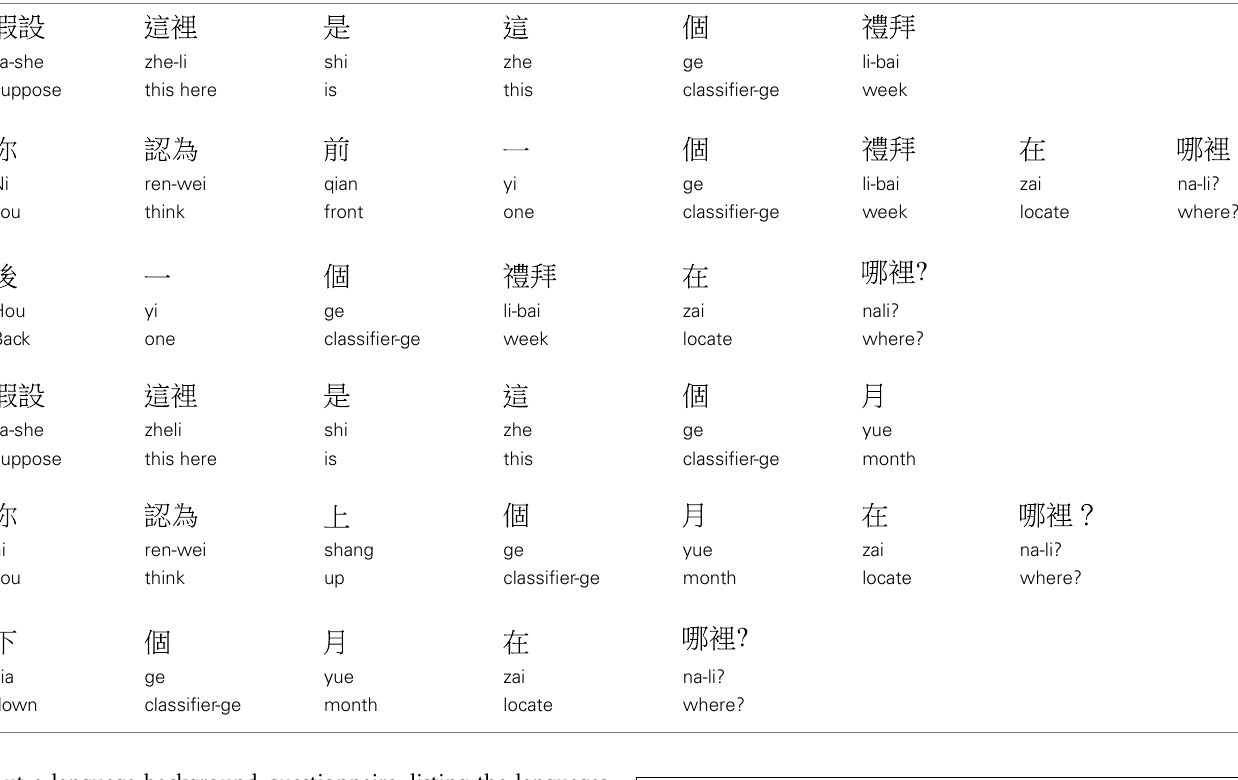
Table 4 | Example test questions using front-back and up-down metaphors in Mandarin.